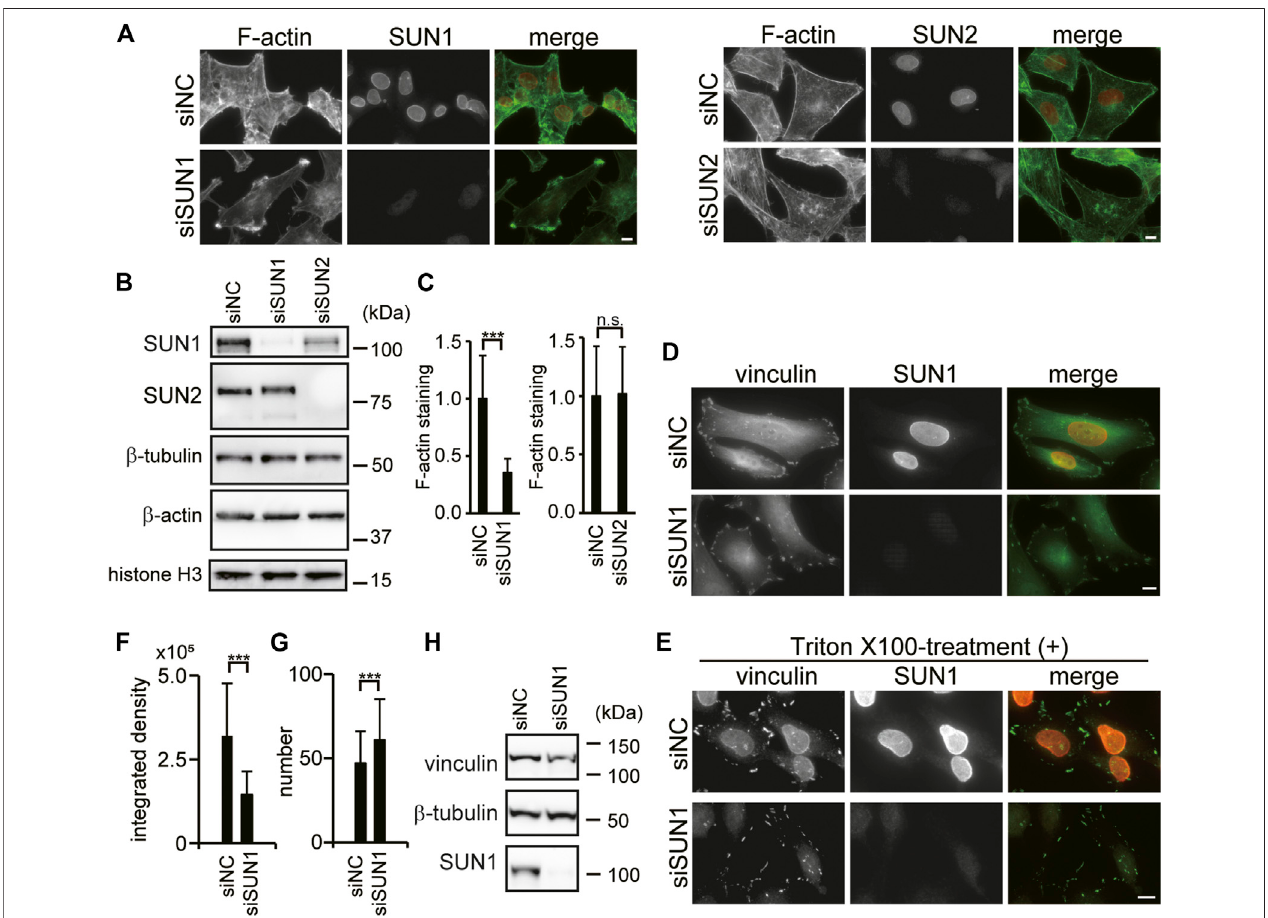
FIGURE 1 | SUN1 depletion affects actin fi lament and suppresses vinculin incorporation into FAs. (A) HeLa cells were transfected with siRNA against SUN1 (siSUN1), SUN2 (siSUN2), or negative control siRNA (siNC) and stained with rhodamine – phalloidin and anti-SUN1 or anti-SUN2 pAb. Scale bar, 10 μ m. (B) Cells were transfected with indicated siRNAs. The expression of SUN1, SUN2, β -tubulin, histone H3, and β -actin proteins in the total cell lysate was analyzed by western blotting. (C) Actin staining intensity in the cytoplasm was quanti fi ed. The values represent the mean of relative intensity to the siNC-transfected cells ±standard deviation (SD). *** p < 0.005 compared withthe siNC-transfected cells. (D) Cellsweretransfected withsiSUN1or siNC, and next fi xedand stained with anti-vinculin mAb and anti- SUN1 pAb. Scale bar, 10 μ m. (E) Cells were transfected with siSUN1 or siNC and treated with 0.5% Triton X-100 for 5 min on ice. Cells were subsequently fi xed and stained with anti-vinculin mAb and anti-SUN1 pAb. Scale bar, 10 μ m. (F , G) Triton X-100 resistant vinculin signal in siNC and siSUN1 transfected cells were quanti fi ed using the ImageJ software. The values represent the mean of the integrated density of vinculin (F) and the number of vinculin dots per cell (G) ± standard deviation